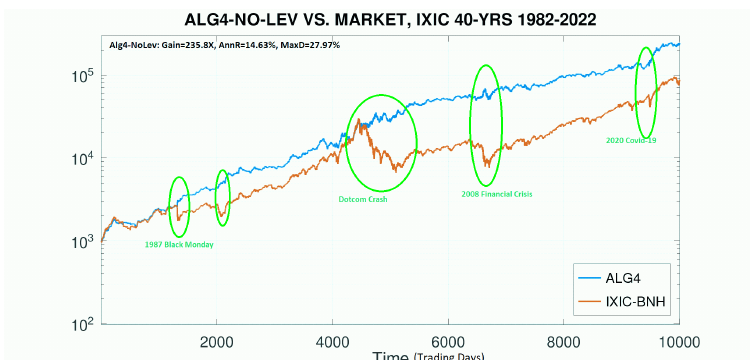
Figure 13. Performance of an algorithm without leveraging, showing valuable gains, as well as markedly reduced drawdowns. Such an approach is immune to interest rate fluctuations and represents our strongest case yet on the utility of sensible market timing. Notice that we actually profit from the 1987 Black Monday and COVID-19